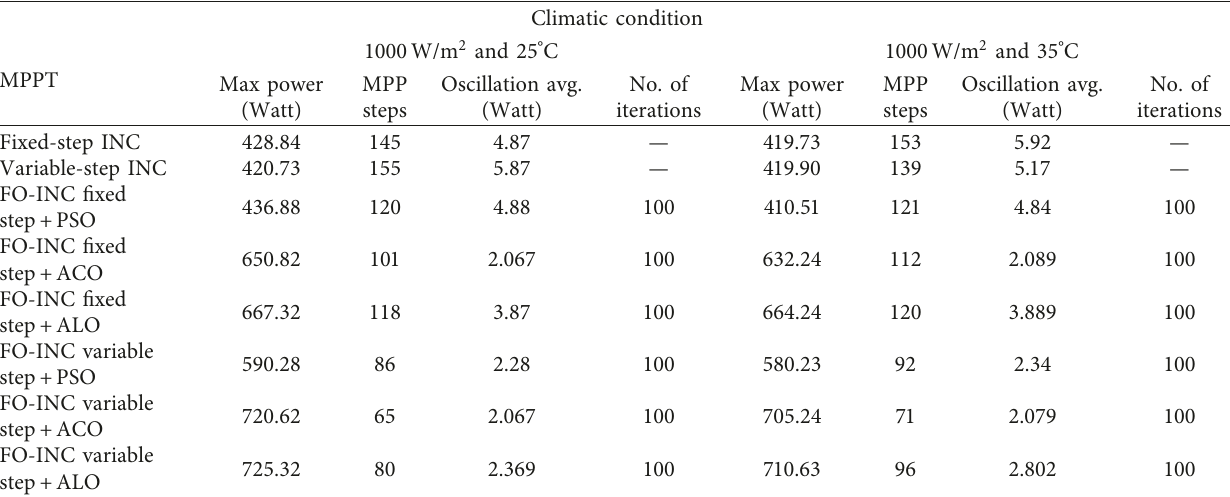
Table 4: Comparative results between MPPT algorithms at 1000W/m 2 Climatic